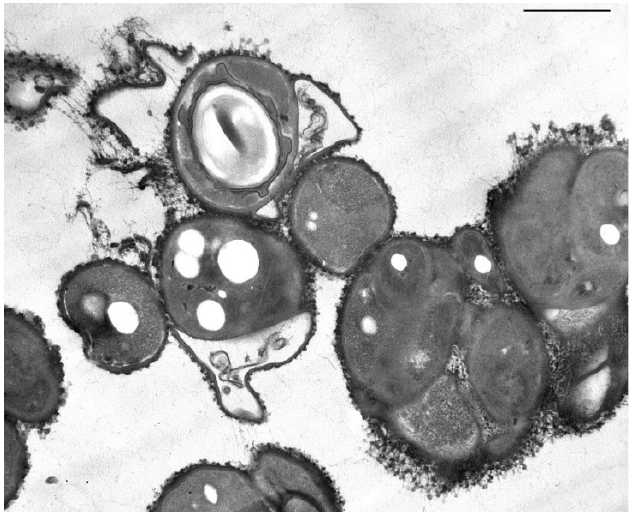
Figure 3. Ultrathin section of cleaving cells of Bacillus aryabhattai str. 25 in a conglomerate (bunch). Some cells in the conglomerate are ultrasmall (less than 300 nm in diameter). Transmission Electron Microscopy. Bar—1